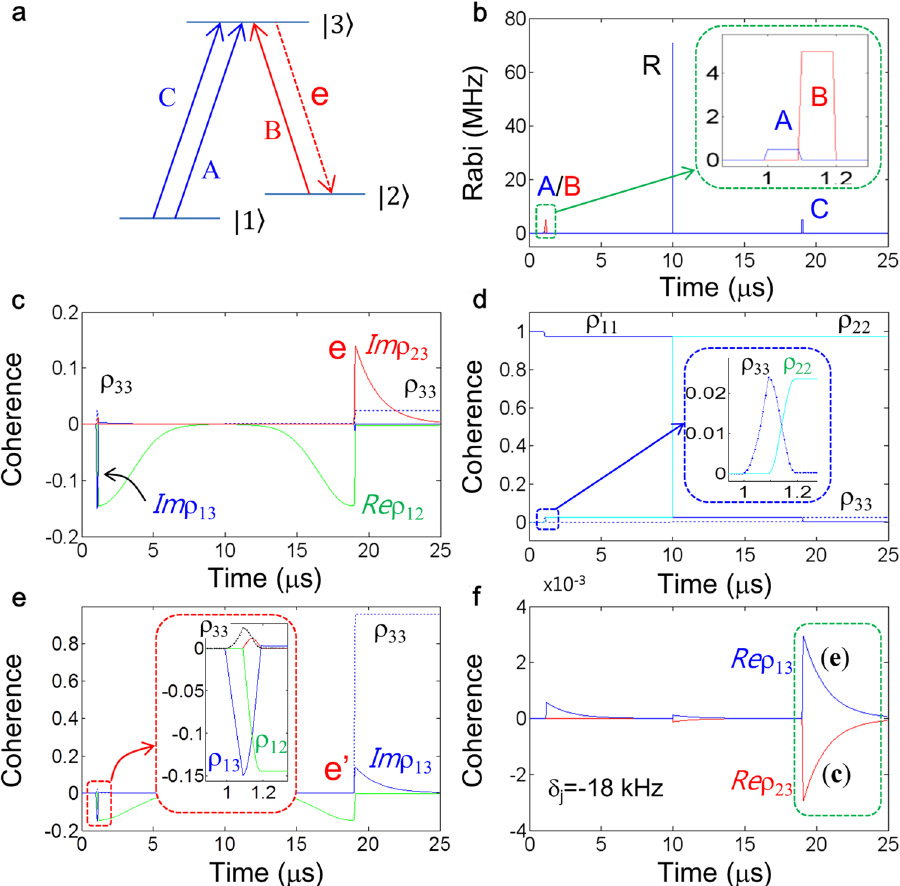
Figure 1. Controlled echo in a spin inhomogeneously broadened three-level optical ensemble. ( a ) A lambda- type energy level diagram interacting with optical pulses. ( b ) Pulse sequence of ( a ). Resonant Raman rephasing pulse R is composed of equal Rabi frequency of A and B. The control pulse C is resonant for the transition of either ⟩ ⟩ | − | 1 3 or − 2 3 . The pulse arrival time of A, B, R, and C is t s 1 0 t s 19 0 C = . μ , respectively. Each pulse duration is 0.1 μ s except for R at 0.01 μ s. ( c ) and ( d ) Coherence and population evolutions for ( a ) and ( b ). Blue: Im ρ 33 , Red: Im ρ 23 , Green: Re ρ 12 , Cyan: ρ 22 , Dotted: ρ 33 . ( e ) Numerical results when C is for 2 3 − transition: ρ 33 ≫ ρ 11 at t > t e , (19.1 μ s). ( f ) Coherence evolutions of real components for two different access of C for ( c ) and ( e ) (overlapped). The detuning δ j is for the j th detuned spin. All decay rates are zero except for phase relaxation rates γ 31 = γ 32 = 50 Hz. The spin inhomogeneous width (FWHM) of − 1 2 transition is 170 kHz. The Rabi frequency of R is Ω = 100/ 2 Ω A , Ω B , and Ω C is 0.5, 5, and 5 MHz, respectively. All numbers in decay rates and Rabi frequencies are divided by 2 π